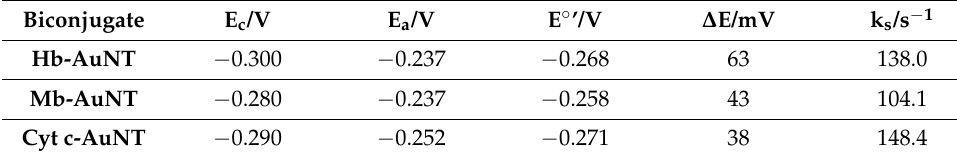
Table 1. Electrochemical parameters obtained from the analysis of the bioconjugates.